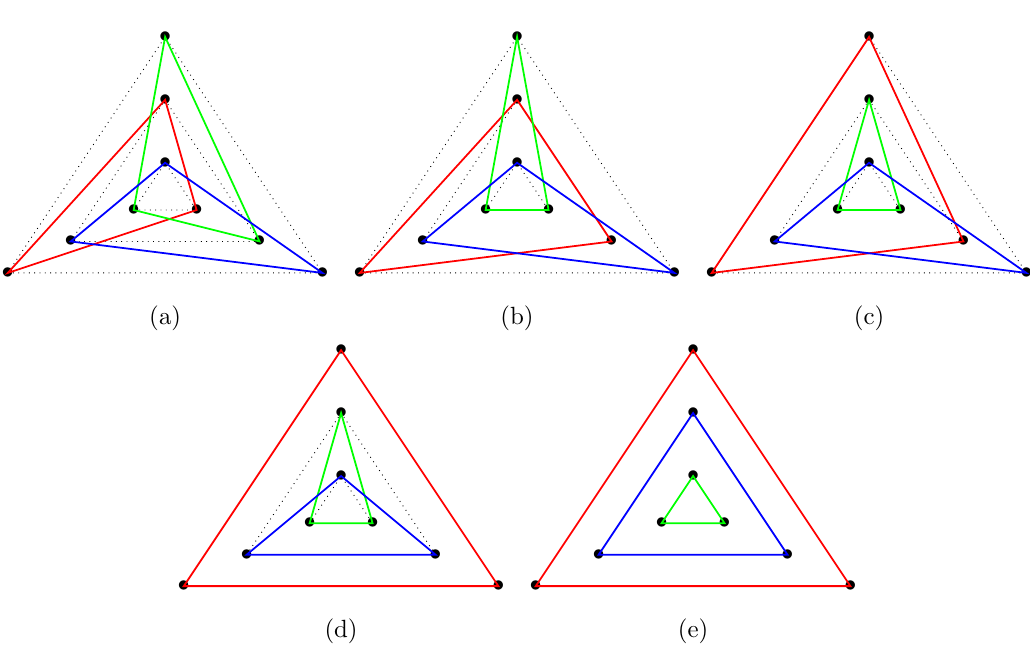
Figure 12. Con(cid:12)gurations of three closed triangles for three parallel C P 2 branes. All of the shown con(cid:12)gurations can be deformed into each other by a continuous family of solutions. Hence, all con- (cid:12)gurations have identical potential energy, but the (cid:13)uctuations around each background can di(cid:11)er.